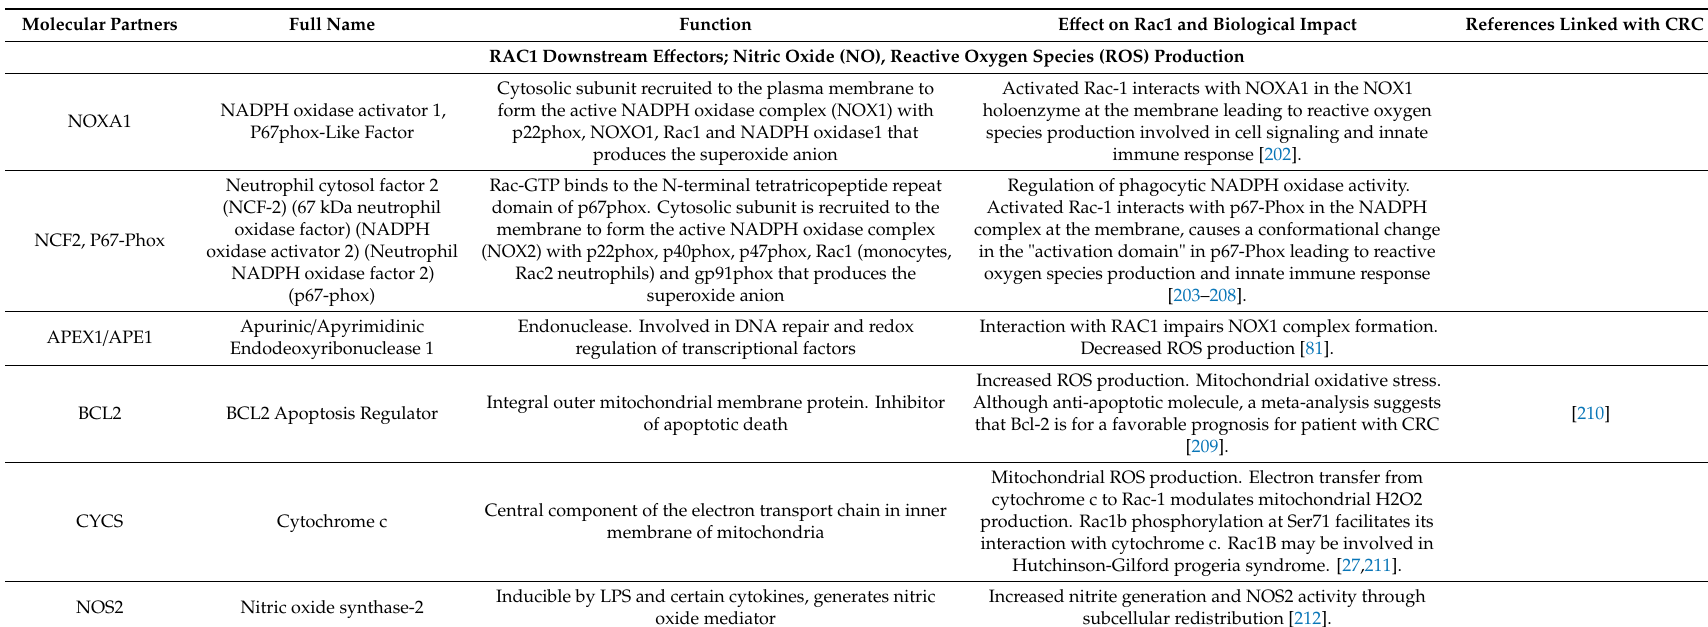
Table 3. Interacting partners and functional